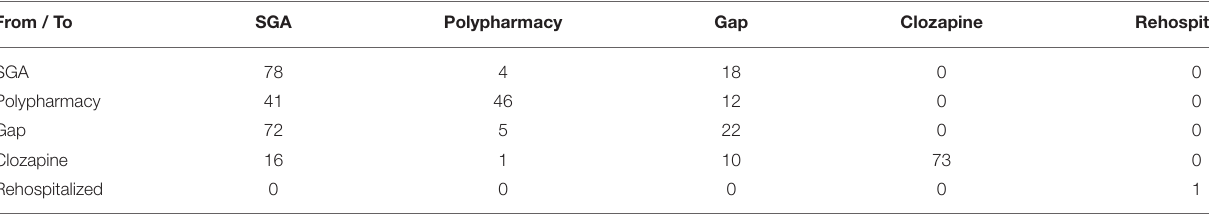
TABLE 3 | Probability of transitioning to (remaining in) a state from a given state at 3 months. From / To SGA Polypharmacy Gap